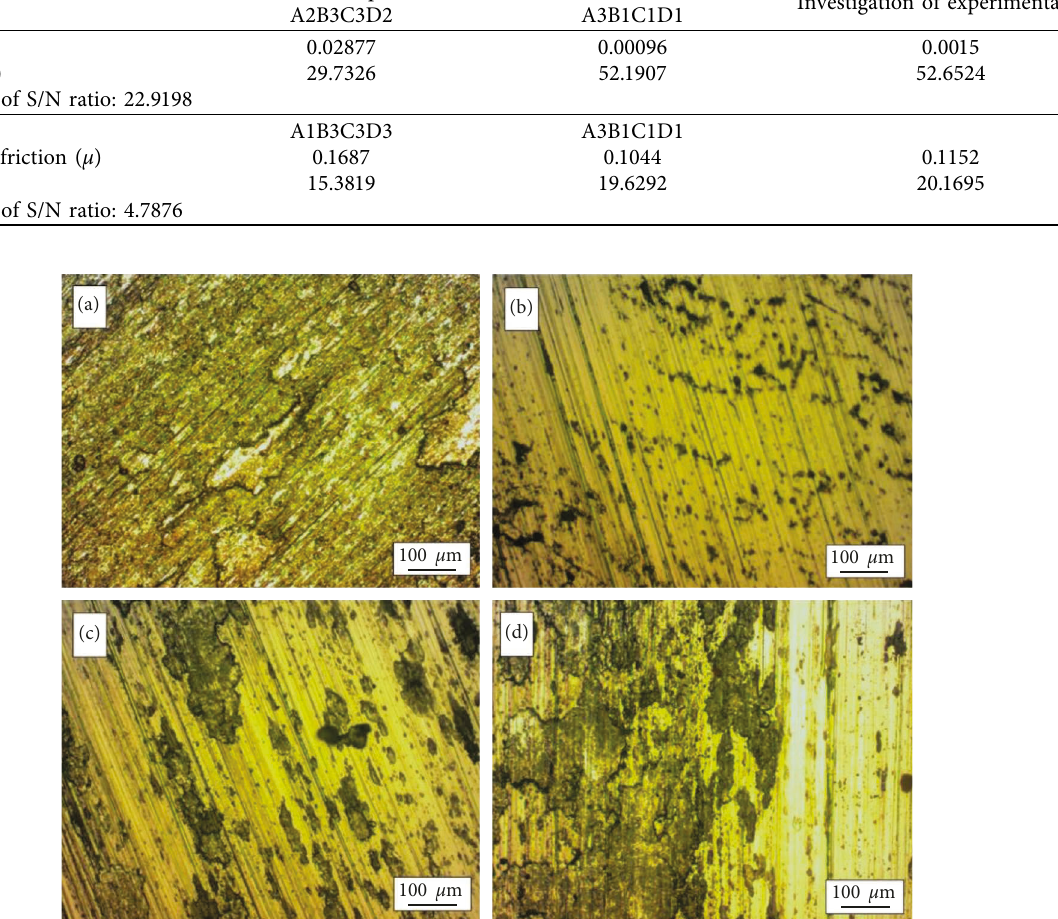
Figure 8: Optical micrographs of fractured topography of disc mated with (a) AA 2024 (b) AA 2024/5% SiC (c) AA2024/5% SiC/5% Gr (d) AA2024/5% SiC/10% Gr nanocomposite with an applied load of 15N and at a constant speed of 1.5m/s.